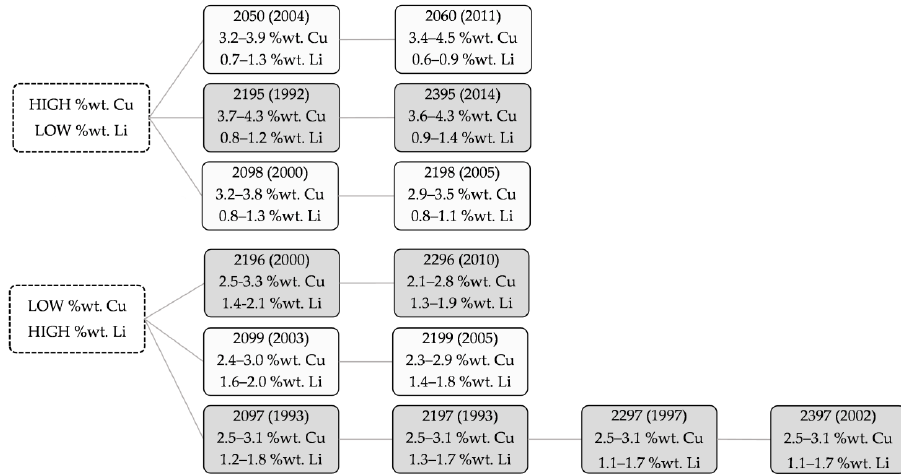
Figure 3. Scheme of the most used Al-Cu-Li alloys.